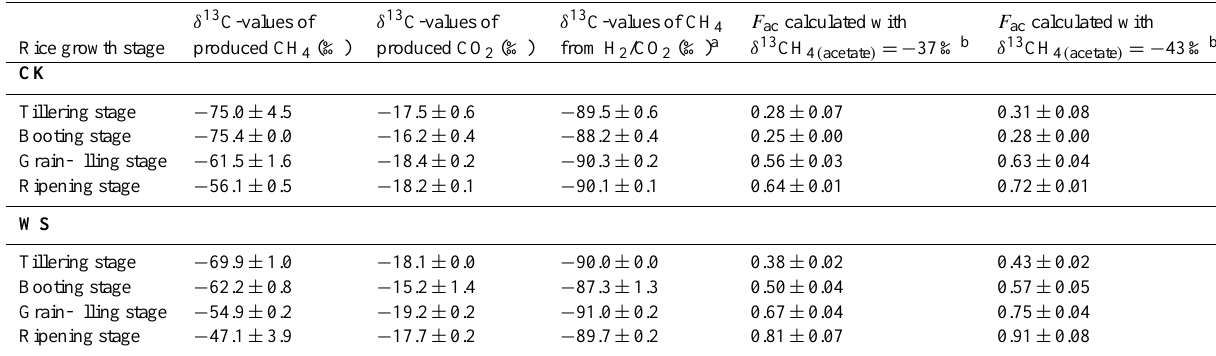
Table 4. Contribution of acetate-dependent CH 4 production ( F ac ) in paddy soil at the four rice growth stages; mean ± SD, n = 3. WS: straw incorporation, CK: without straw incorporation.